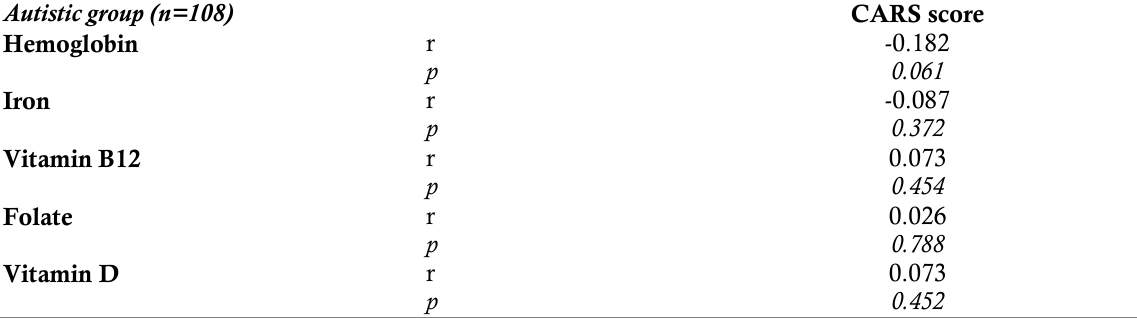
Table 8. Correlation of CARS Scores and Vitamin and Mineral